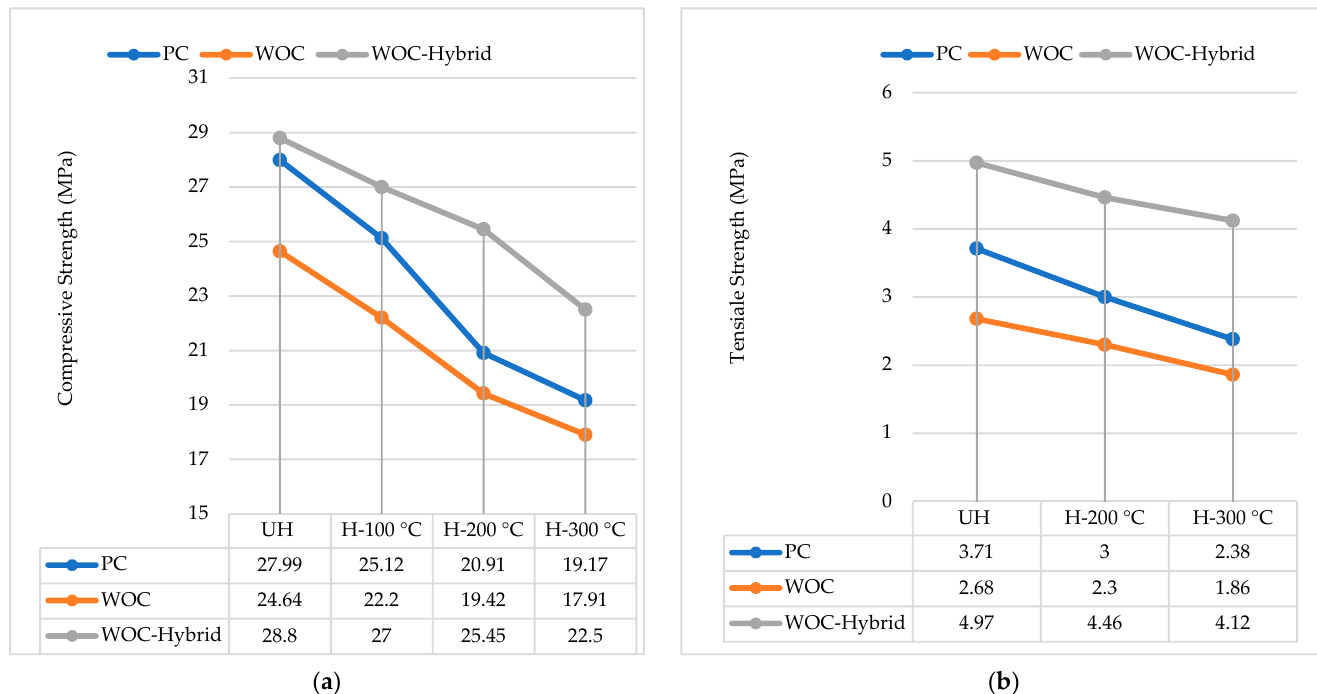
Figure 10. PC, WOC, and WOC-Hybrid cylinder at failure after exposure to elevated temperatures 300 °C.